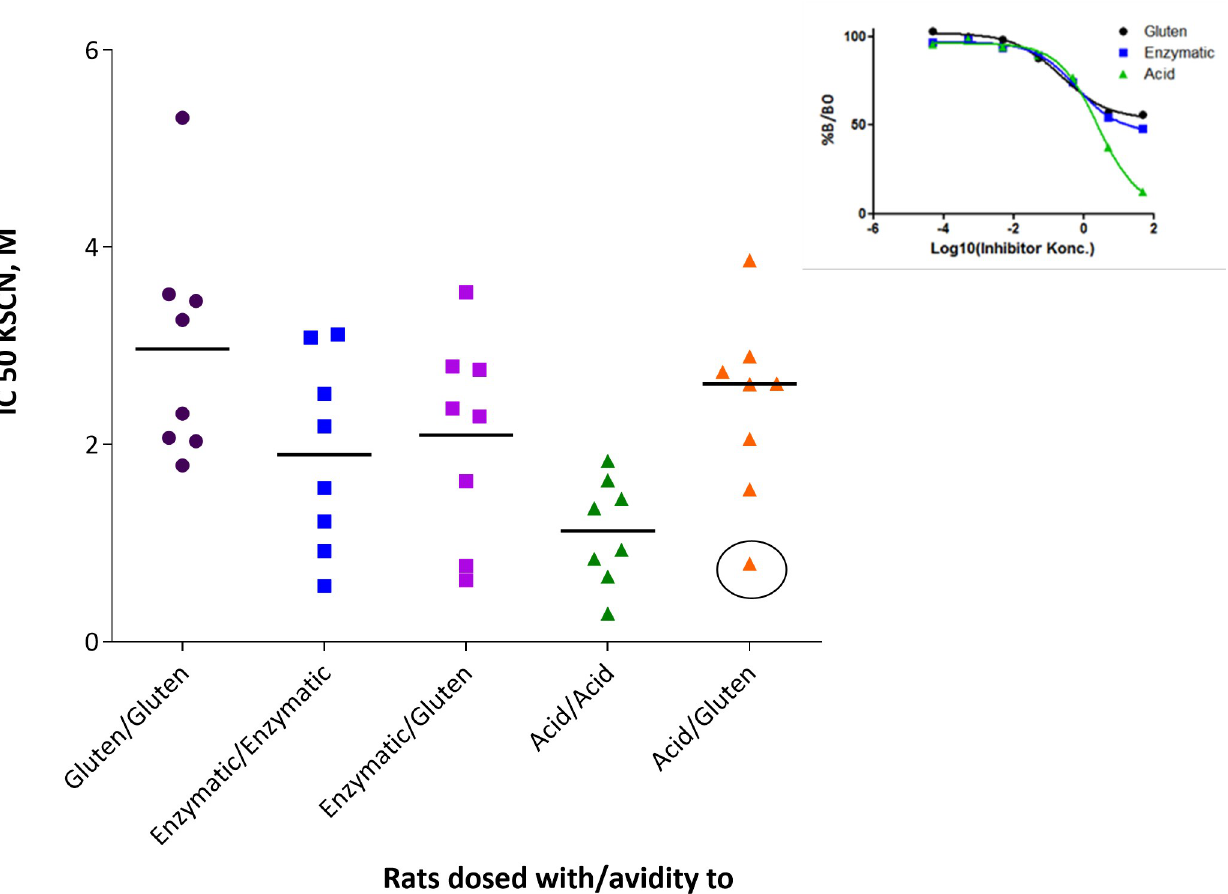
Fig 4. Avidity to the product used for immunization in gluten tolerant rats and to gluten in rats immunized with enzymatic and acid hydrolyzed gluten. The insert is the inhibition ELISA for the rat in the circle.